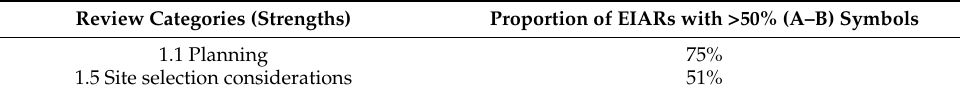
Table 10. Areas of strengths (A-B) in the EIARs assessed for their